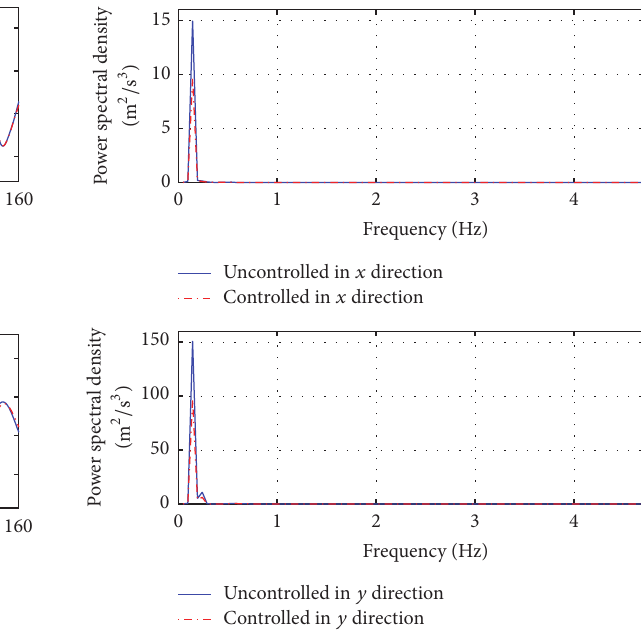
Figure 7: Dynamic responses of the tower turret under wind load.